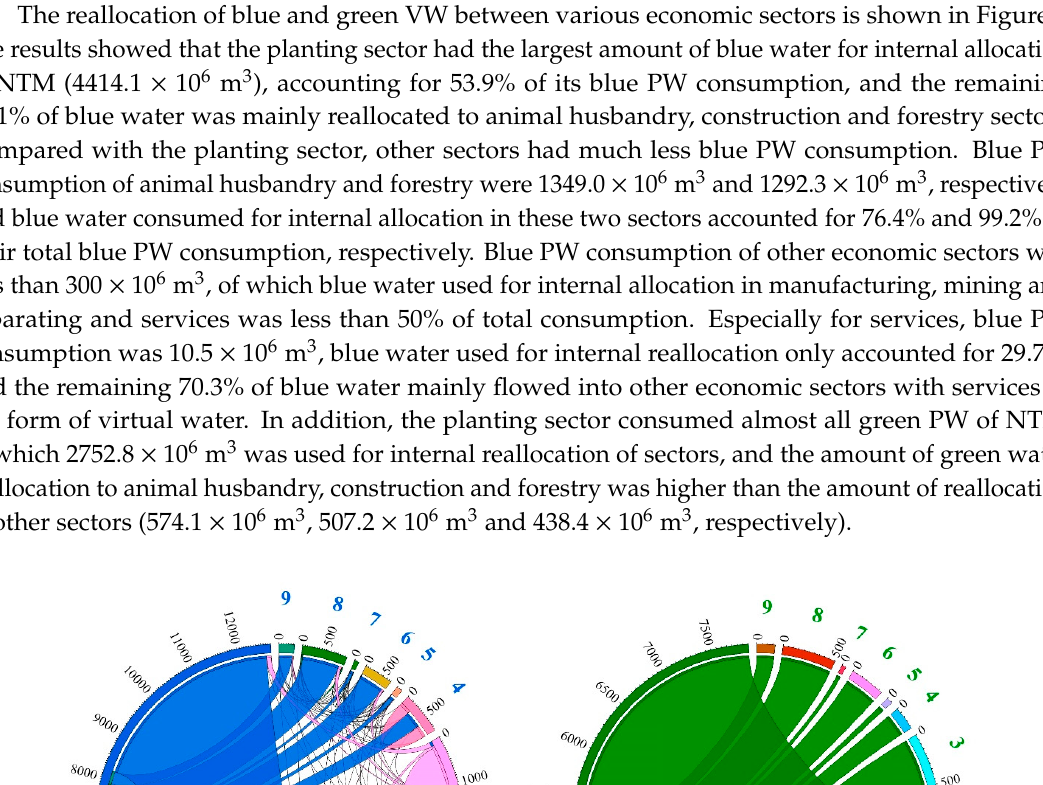
Figure 3. Reallocation of blue water and green water between different economic sectors in NTM.